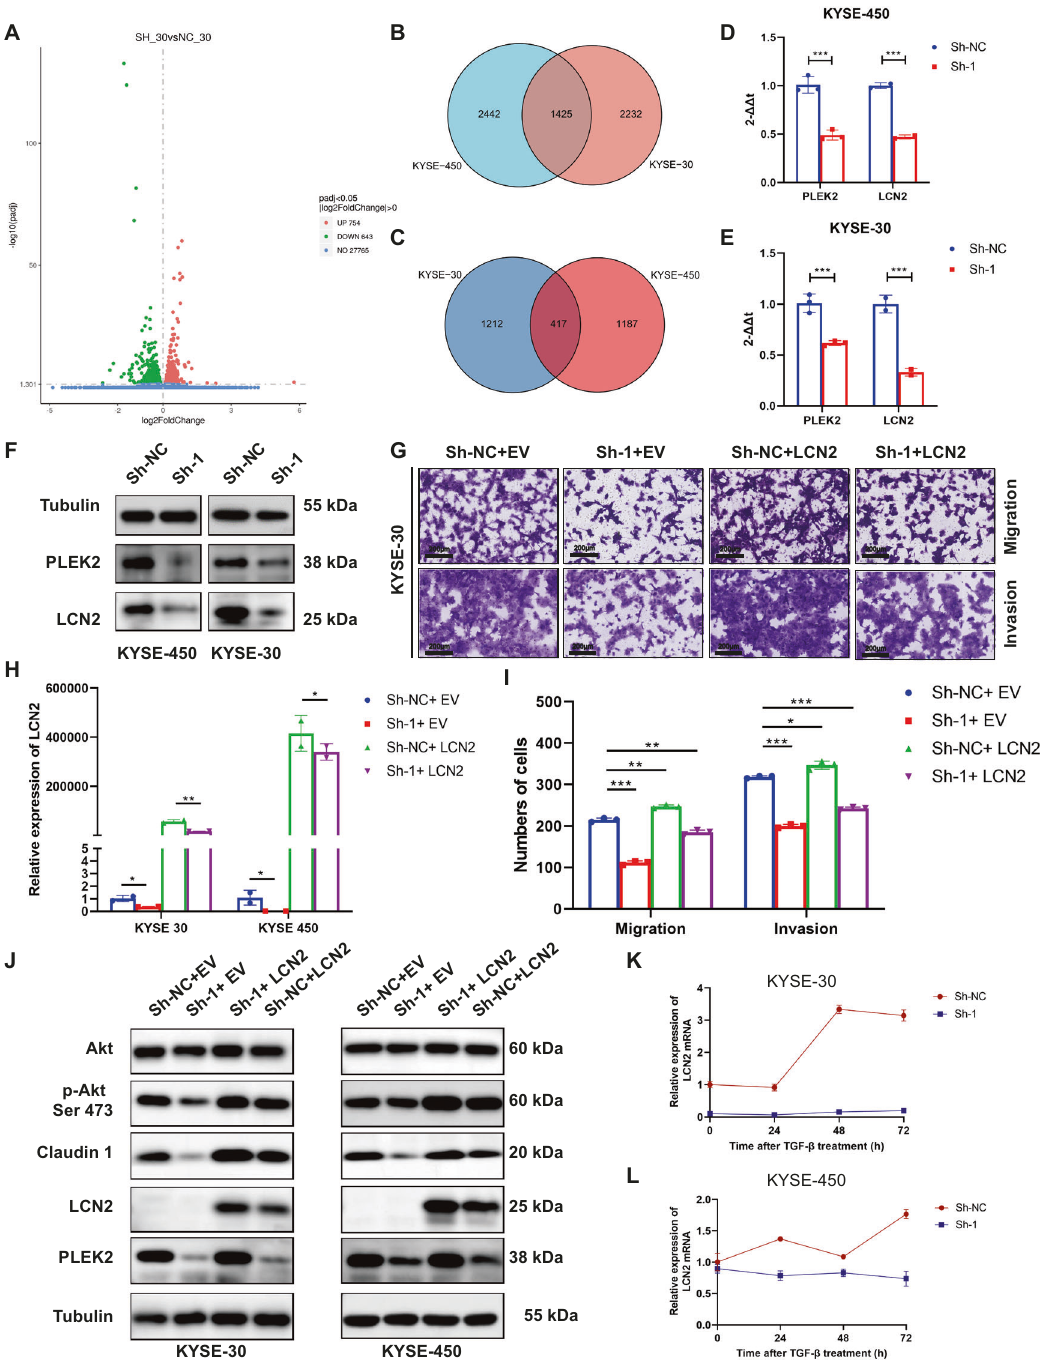
Fig. 6 LCN2 is detected to be directly regulated by PLEK2. A Volcano plot of differential genes expression after PLEK2 was stably knockdown in KYSE-30 cells. B The Venn diagram showed number of differential upregulated genes in PLEK2 stably knockdown cells; C The Venn diagram showed number of differential downregulated genes in PLEK2 stably knockdown cells; D The expression of PLEK2 and LCN2 in PLEK2 knockdown KYSE-450 cells on the mRNA level; E The expression of PLEK2 and LCN2 in PLEK2 knockdown KYSE-30 cells on the mRNA level; F The expression of PLEK2 and LCN2 in PLEK2 knockdown KYSE-30 and KYSE-450 tested by western blot. The expression of LCN2 in PLEK2 knockdown cells which treated with TGF- β on the mRNA level; G The migration and invasion ability of PLEK2 knockdown cells with or without LCN2 overexpression; H Overexpression of LCN2 in PLEK2 knockdown cells and its ef fi ciencies were detected on the mRNA level; I Quali fi cation of number of cells that migrated through the membrane or invaded through the membrane; J Western blot analysis of PLEK2 Claudin-1, AKT, p-AKT, and LCN2. Tubulin was used as loading control; K The expression of LCN2 in PLEK2 knockdown KYSE-30 which treated with TGF- β on the mRNA level; L The expression of LCN2 in PLEK2 knockdown KYSE-450 which treated with TGF- β on the mRNA level; * P < 0.01; *** P < 0.01; *** P <